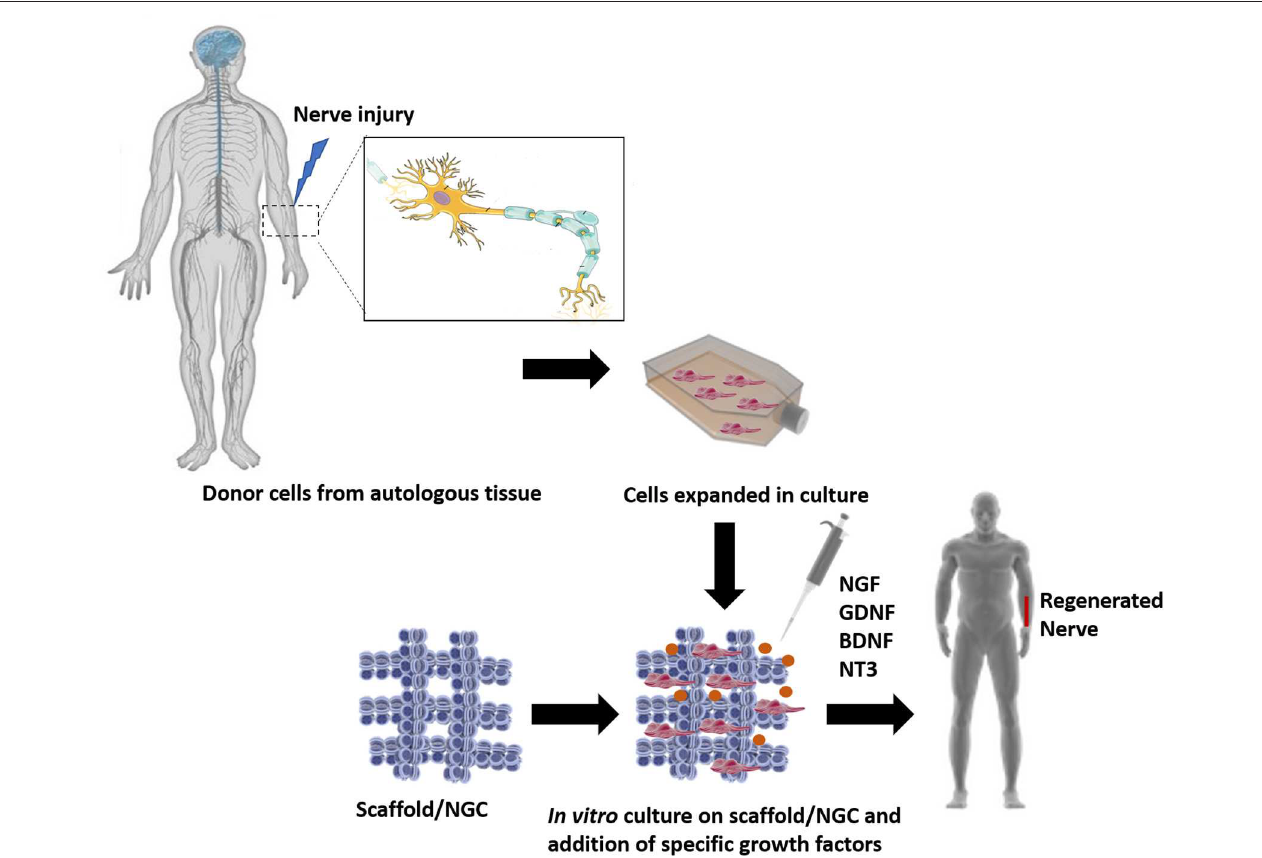
FIGURE 3 | The classic TE model, where a triad of components interact with each other: scaffolds, cells and biological molecules. Overall, it includes the combination of living cells isolated from the patient donor tissue (nerve) and expanded in culture, with a natural, synthetic, or bioartificial matrix or scaffold. Together with the addition of biological stimuli such as growth factors, a 3D living construct that is structurally, mechanically, and functionally equal to a nerve tissue. The engineered construct can be implanted in the patient in order to restore the damaged